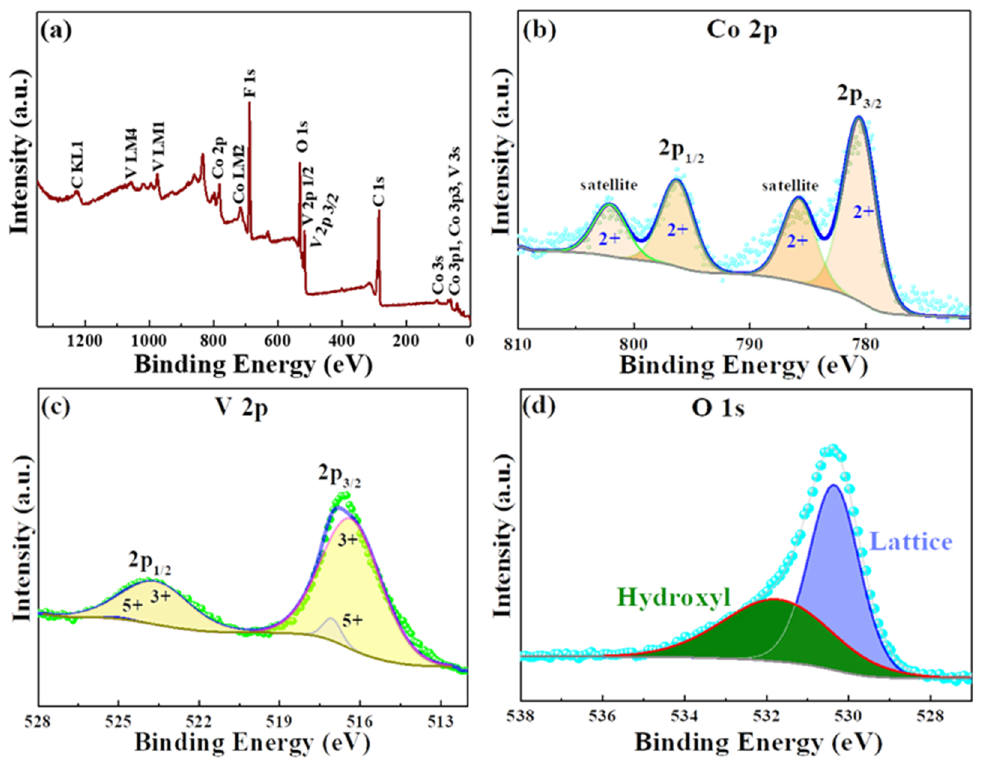
Figure 3. XPS spectra of the CoV 2 O 4 sample: ( a ) wide range spectra; ( b ) Co 2p core spectra; ( c ) V2p core spectra; and ( d ) O1s core spectra.